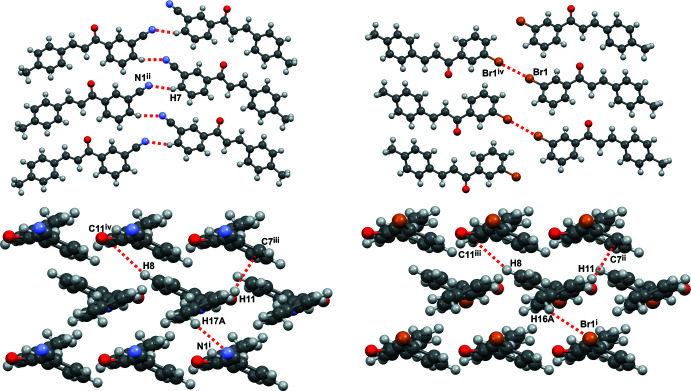
Selected packing displays for m′CNpCH3 (left) and m′BrpCH3 (right) showing identical lateral inter­actions for C16—N1⋯H7 and the Br1⋯Br1 type I halogen bond (top), as well as the stacking inter­actions N1⋯H17A, C11⋯H8, C7⋯H11, and Br1⋯H16A (bottom). The symmetry codes apply to those mol­ecules inter­acting with the asymmetric unit. Additional N1⋯H7 and Br1⋯Br1 inter­actions are included to serve as a visual aid. Symmetry codes for m′CNpCH3: (i) 1 − x, 1 − y, 1 − z; (ii) −x, − + y,  − z; (iii) −x, 1 − y, 1 − z; (iv) −x, −y, 1 - z. Symmetry codes for m′BrpCH3: (i) 1 − x, 1 − y, 1 − z; (ii) 1 − x, 2 − y, 1 − z; (iii) −x, 2 − y, 1 − z; (iv) 2 − x, 2 − y, −z.